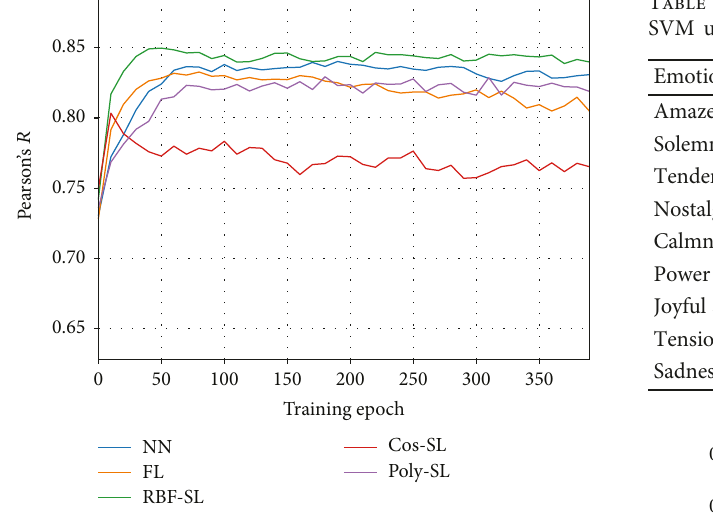
Figure 2: Performance on MediaEval2013 dataset, arousal prediction.